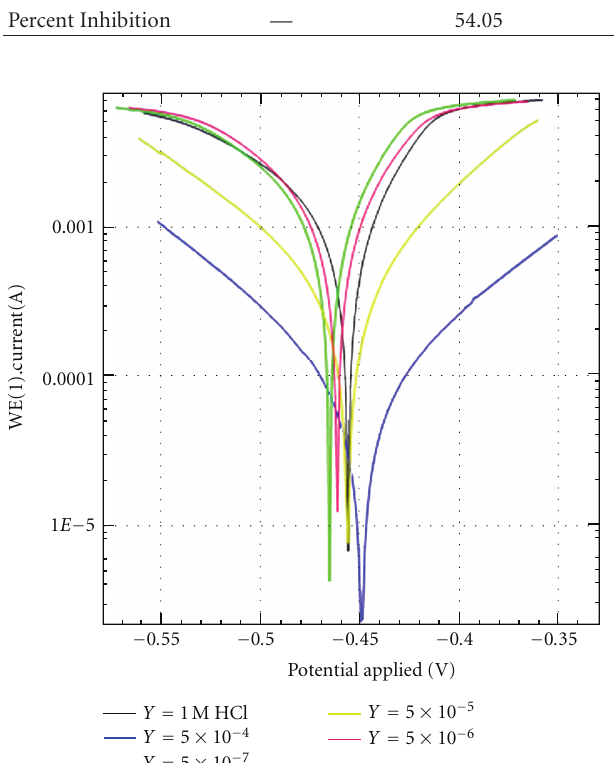
Figure 2: Anodic and cathodic polarization curves of mild steel in an uninhibited 1.0 M HCl solution and in 1.0 M HCl contain- ing various concentrations of 3-benzoylmethyl benzimidazolium hexafluoroantimonate (BMBI) at ambient temperature. (1) 1.0 M HCl; (2) 1.0 M HCl + 5 . 0 × 10 − 7 M inhibitor; (3) 1.0 M HCl +